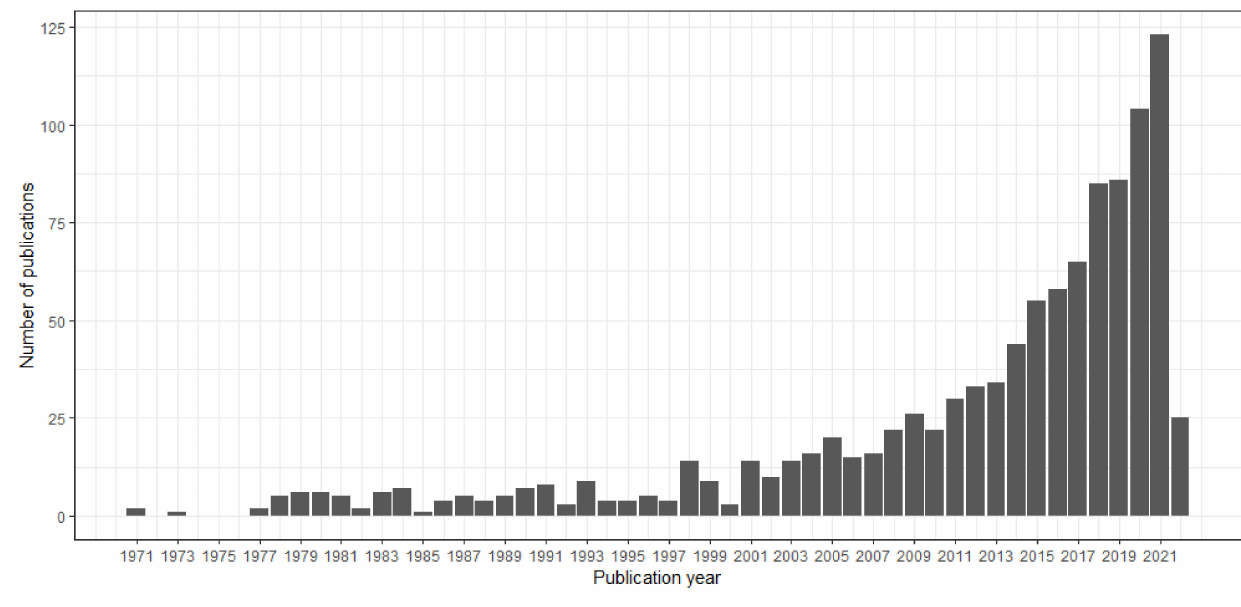
Figure 2. Number of articles related to premature mortality.